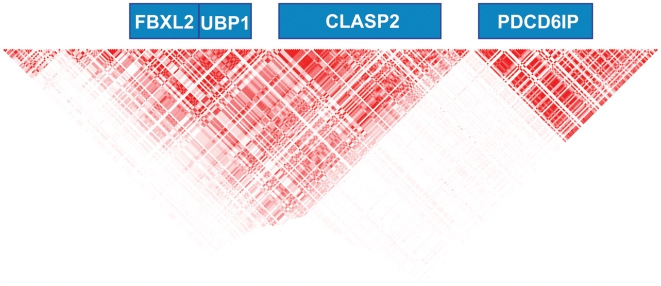
Gene and LD block structure of the human chromosome 3. 33.2–33.9 Mb region.Based on the imputed EUGENE2 data. Dark red color represents perfect LD (R2) of 1 between the markers.